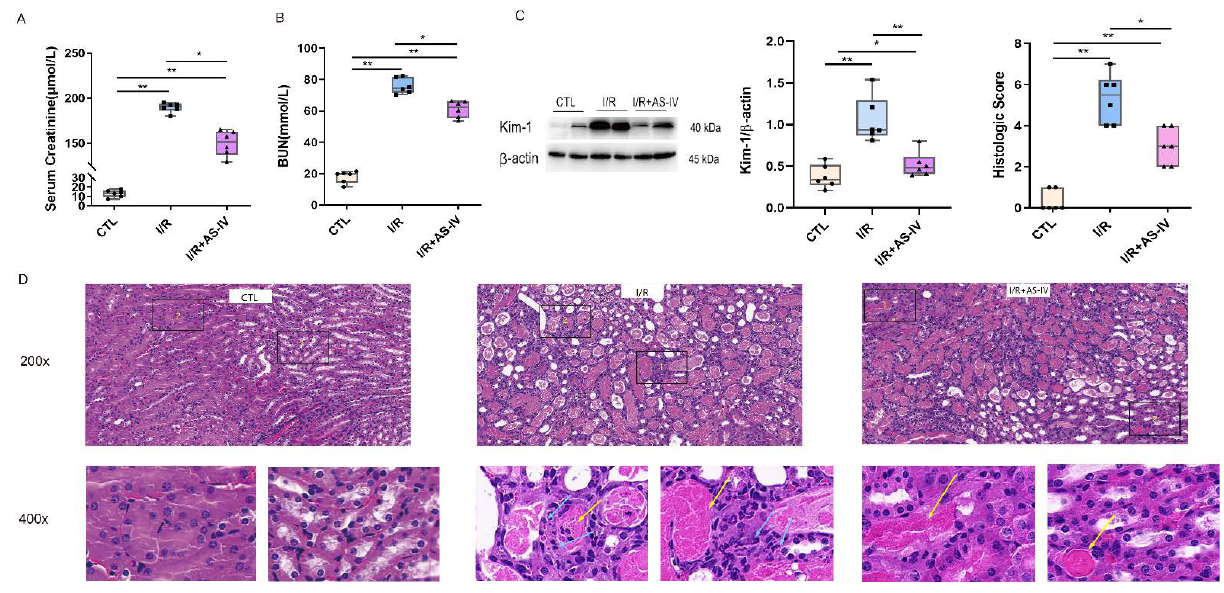
Figure 2. Astragaloside IV reduces acute renal injury induced by ischemia-reperfusion. ( A , B ) The level of serum creatinine and urea nitrogen 24 h after ischemia-reperfusion. ( C ) Western blotting shows the expression of kidney injury molecule-1 (Kim-1) in kidney tissue 24 h after ischemia-reperfusion. ( D ) Representative H&E staining of renal tissue sections 24 h after ischemia-reperfusion (magnification ×200, ×400); blue arrows indicate tubular epithelial cell necrosis with nuclear dissolution or fragmentation and calcification. Yellow arrows indicate eosinophils infiltration. n = 6 in each group, * p < 0.05, ** p < 0.01.